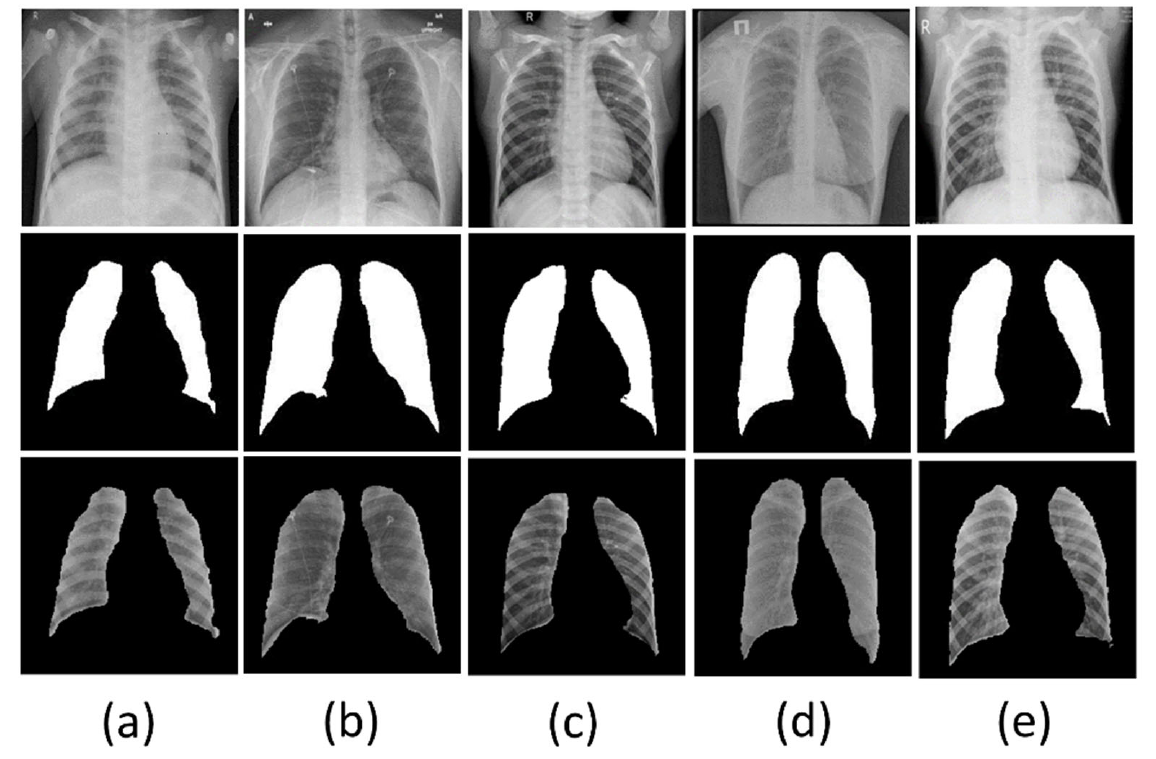
Figure 19. Example of images from classes ( a ): Bacterial Pneumonia, ( b ): COVID-19, ( c ): Normal, ( d ): Tuberculosis, ( e ): Viral Pneumonia; top row: original chest X-ray images, middle row: UNet generated corresponding masks, bottom row: final segmented lung